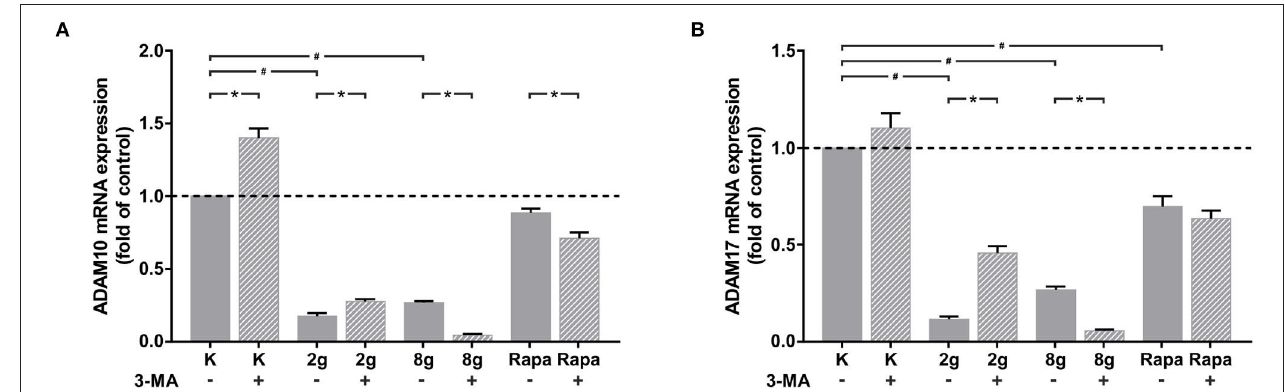
FIGURE 6 | (A) Effects of mechanical stimulation (2 g/cm 2 or 8 g/cm 2 ) or Rapamycin (Rapa; 50 nM) with or without autophagy inhibitor 3-MA on adam10 gene expression at 16 h as determined by rtPCR. Untreated cells served as control. Mean ± SEM ( n = 6); # significant ( p < 0.05) difference between groups as determined by Dunnett’s T -test. ∗ significant ( p < 0.05) difference between two groups (uninhibited and inhibited) as determined by the Mann-Whitney-Test. (B) Effects of mechanical stimulation (2 or 8 g/cm 2 ) or Rapamycin (Rapa; 50 nM) with or without autophagy inhibitor 3-MA on adam17 gene expression at 16 h as determined by rtPCR. Untreated cells served as control. Mean ± SEM ( n = 6); # significant ( p < 0.05) difference between groups as determined by Dunnett’s T -test. ∗ significant ( p < 0.05) difference between two groups (uninhibited and inhibited) as determined by the